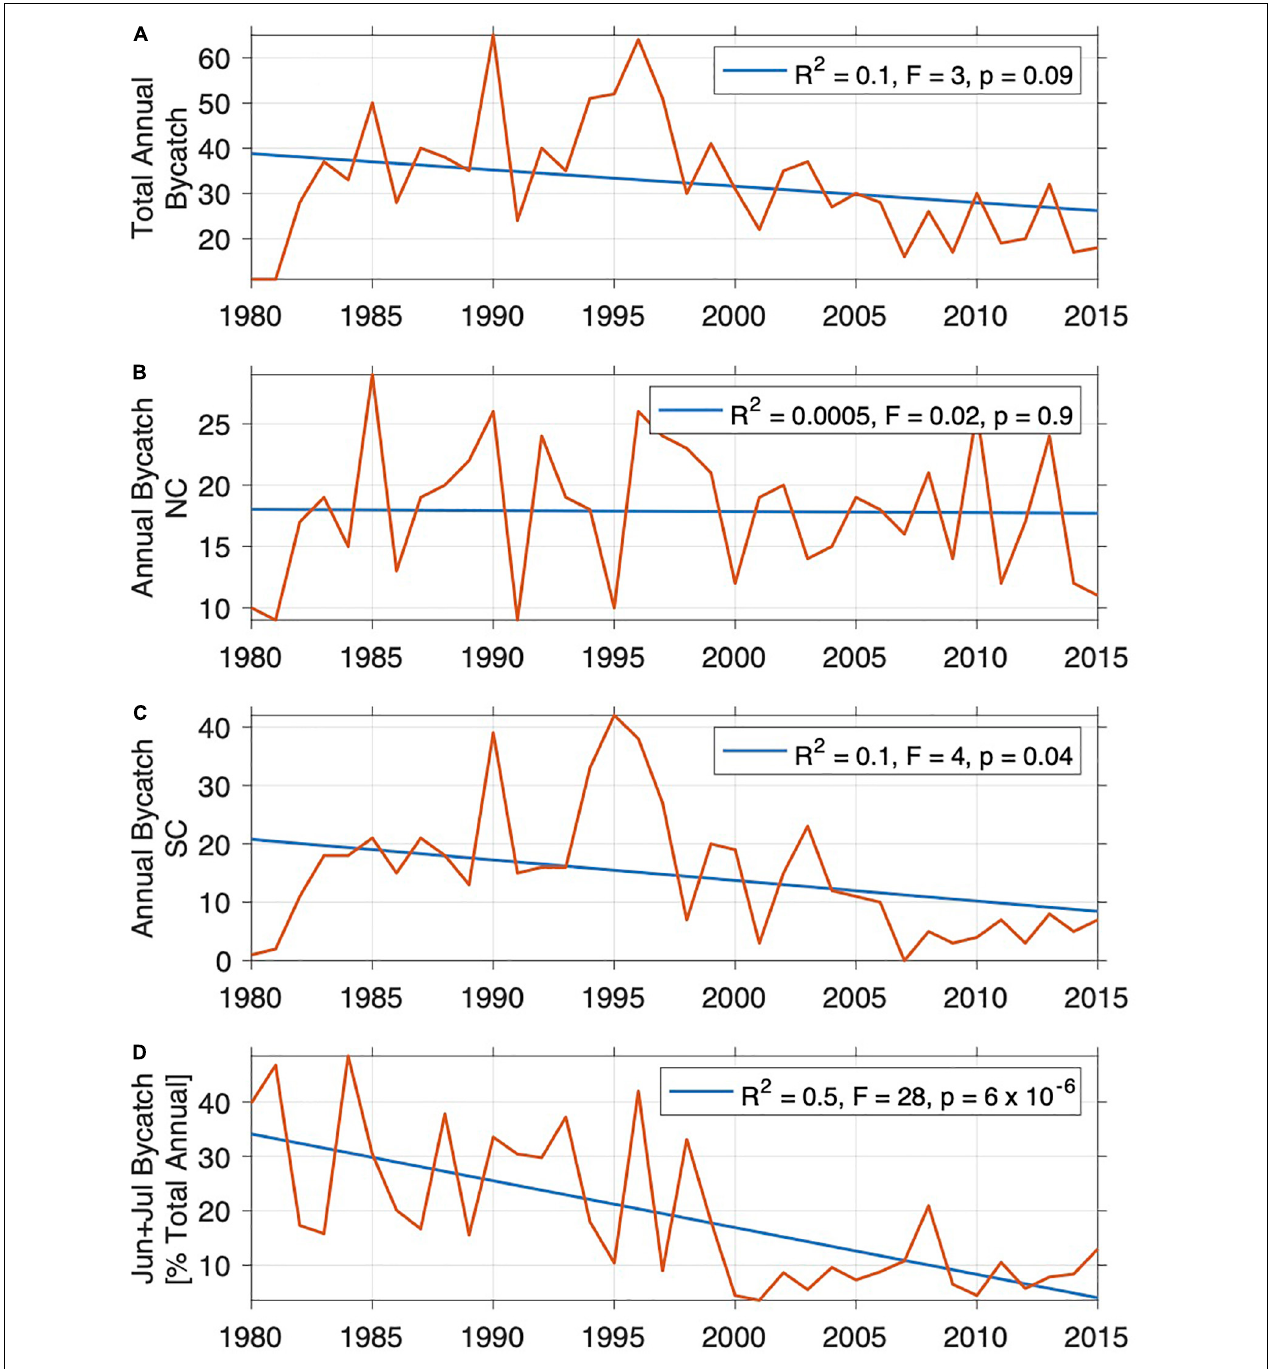
FIGURE 8 | Total annual bycatch [numbers of animals] (A) , split into NC (B) and SC (C) , and bycatch during the months of June and July as a percent of the total annual bycatch (D) . The R 2 -statistic, F-statistic, and p-value for the F-test are given.